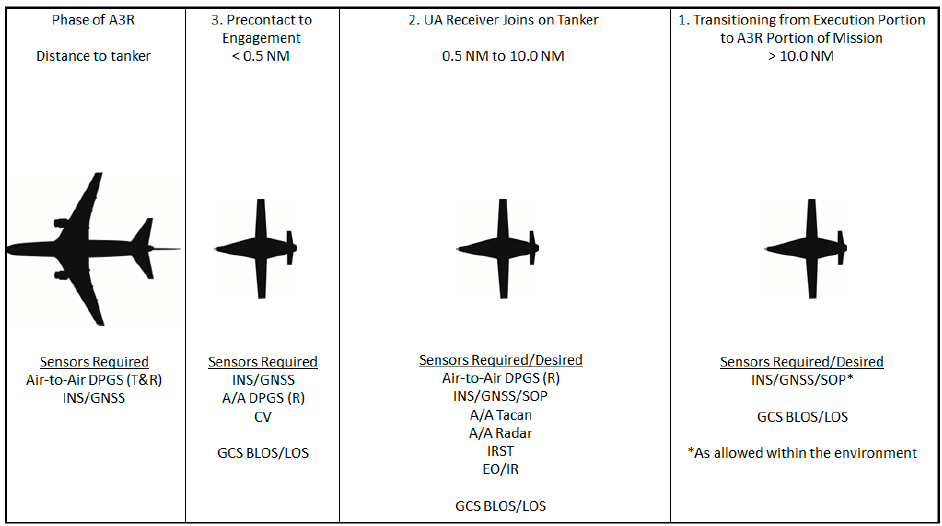
Figure 14. Review of the sensor requirements by phase of flight. Table 1. Summary of the sensors covered.